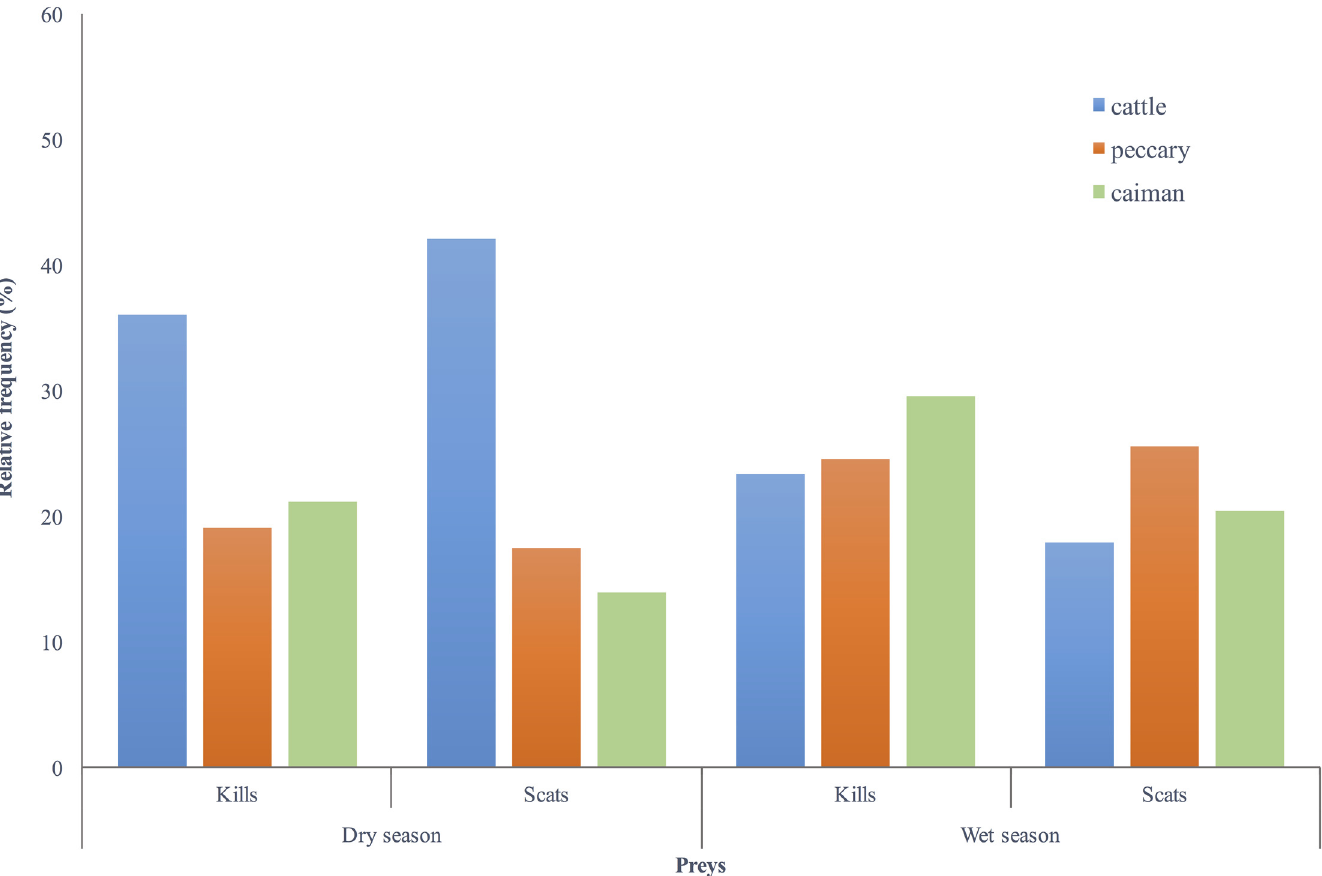
Fig 1. Relative frequency of occurrence of the 3 main prey found in GPS location clusters of 10 radio-collared jaguars (Kills) and in 125 jaguar scats (Scats) during dry and wet seasons from 2001 to 2004. Southern Pantanal, Brazil.